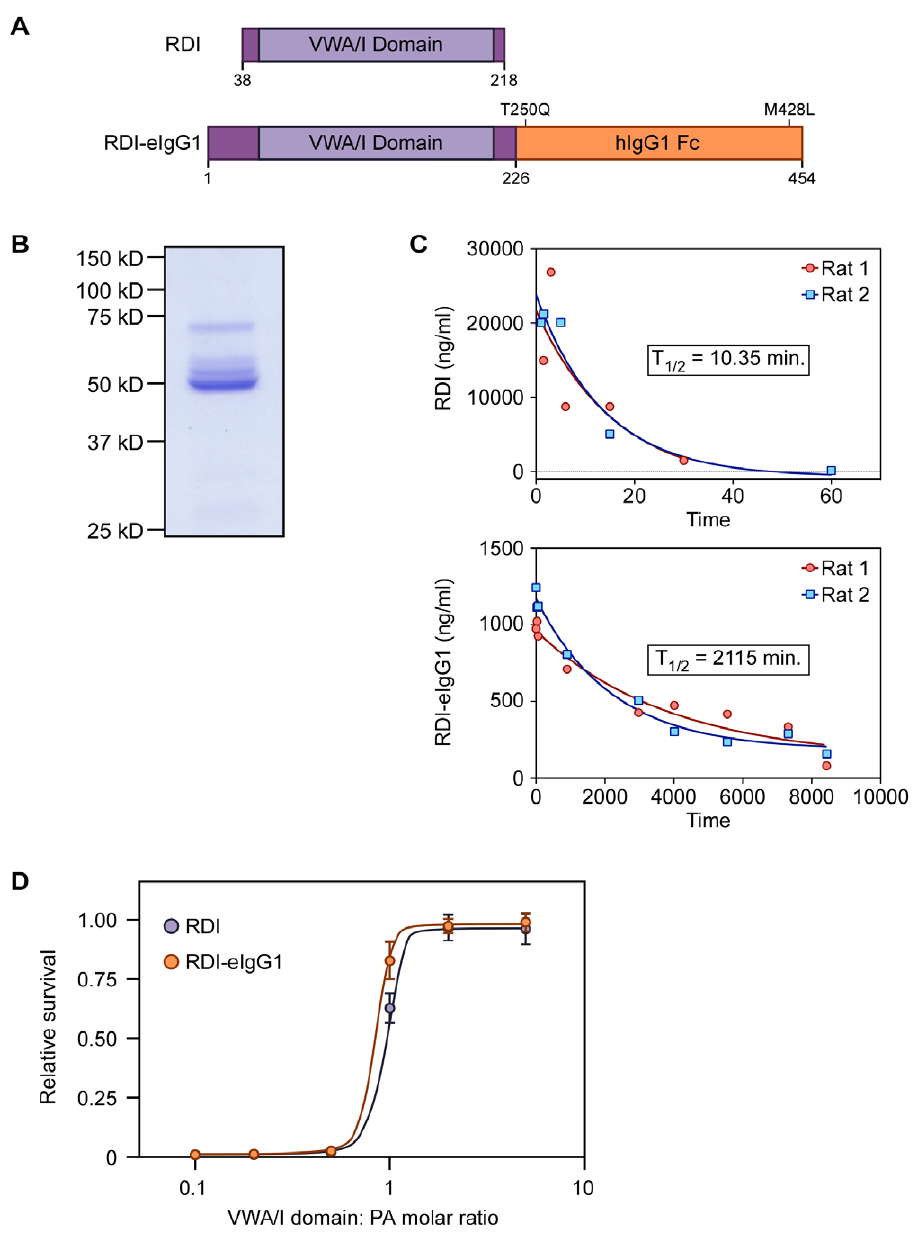
of RDI-eIgG1 separated on a SDS-containing10% polyacrylamide gel. Molecular weight markers are indicated. C. Detection of RDI (top panel) or RDI- eIgG1 (bottom panel) after intravenous injection in 2 rats by ELISA analysis. Curve-fitting and half-life (t 1/2 ) was calculated using Prism (Graph Pad, Inc.) D. Inhibition of LeTx activity in RAW264.7 cells by RDI or RDI-eIgG1.